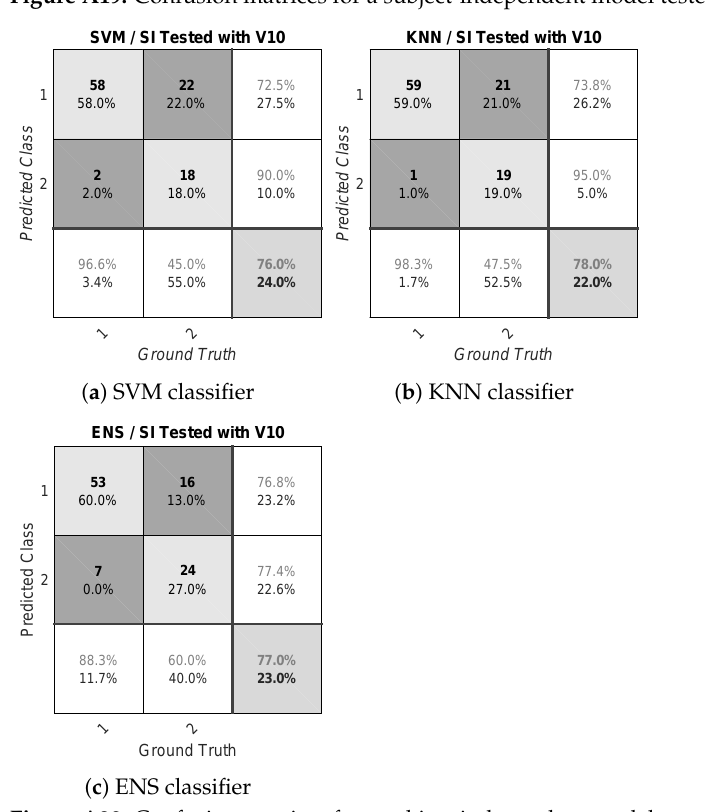
Figure A20. Confusion matrices for a subject-independent model tested with